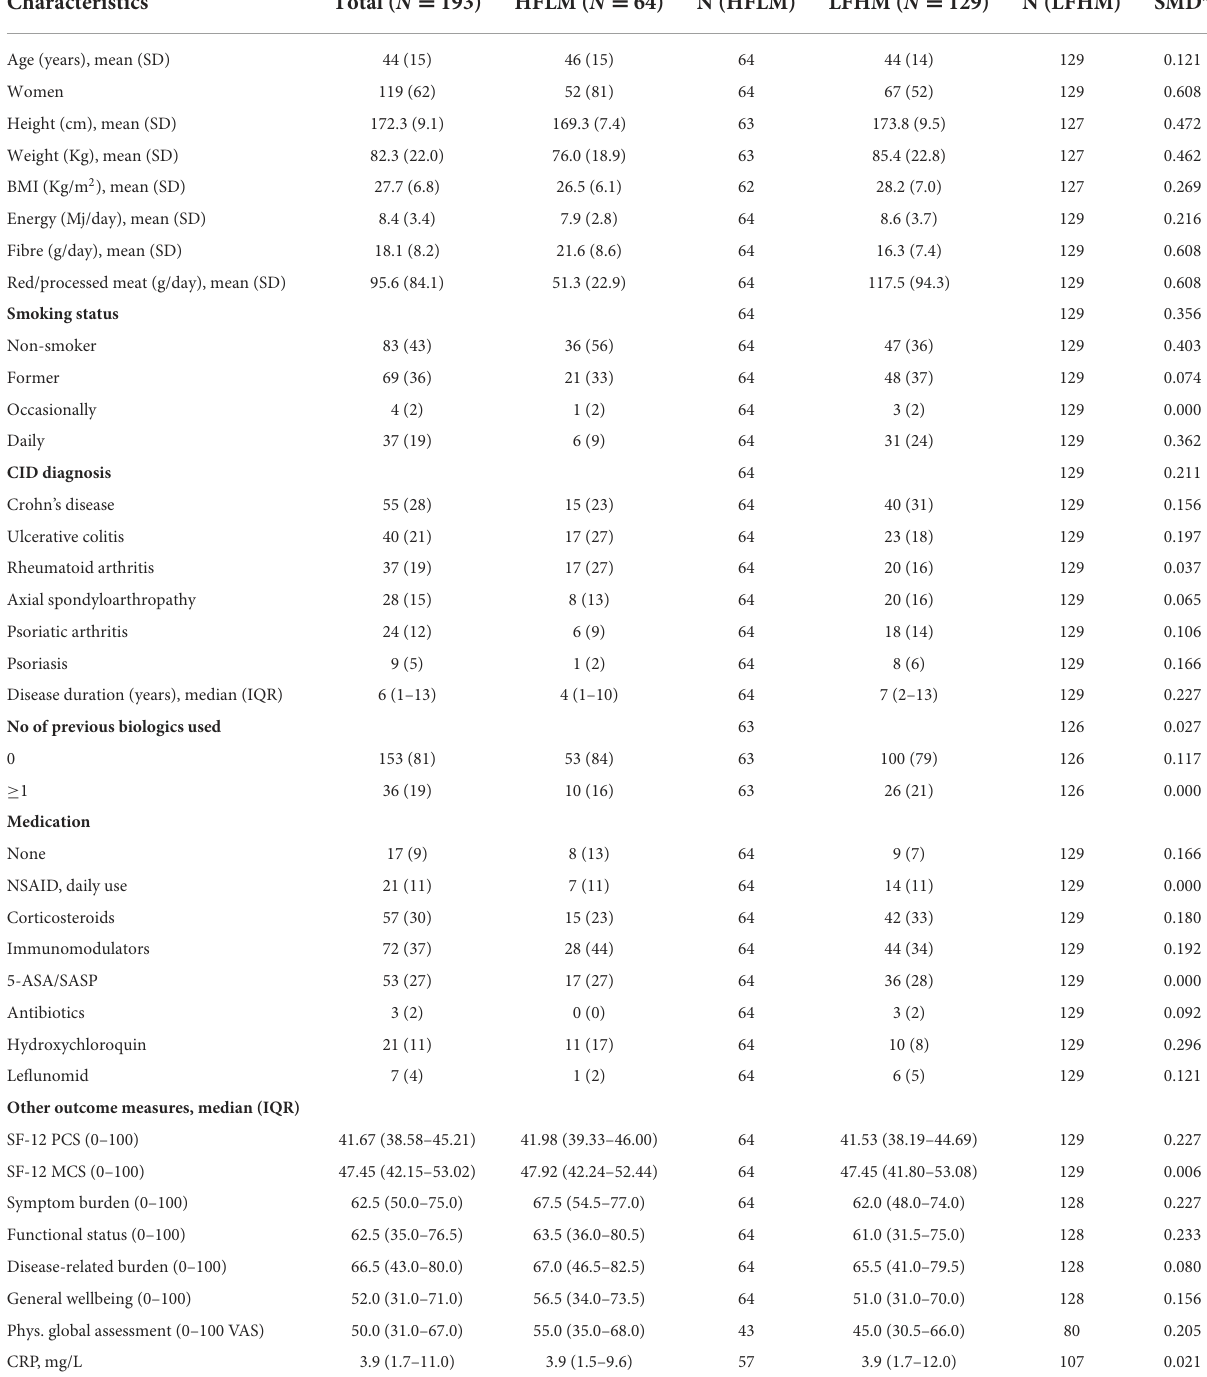
TABLE 1 Selected baseline patient